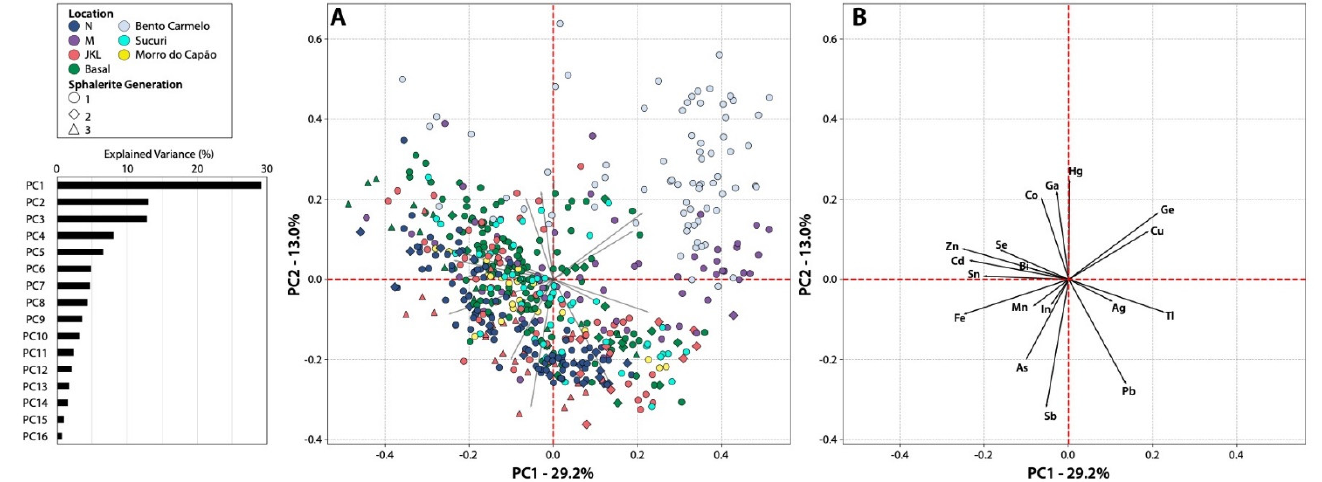
Figure 11. Plot of sphalerite analyses in PC1 (29.2%) vs. PC2 (13.0%) ( A ) and the element components ( B ) with the eigenvalues of the PCs on the left.